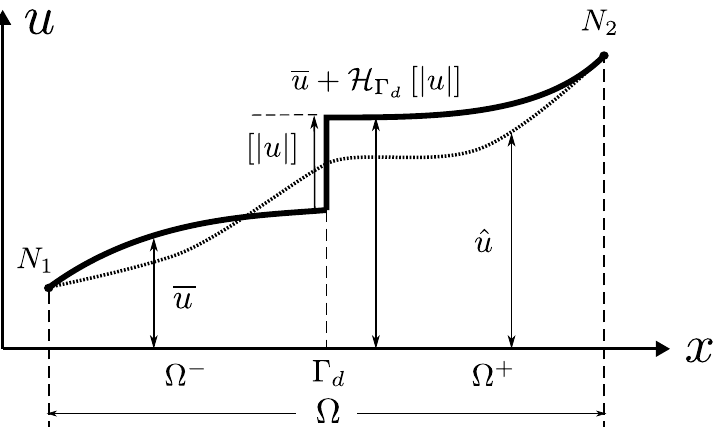
Figure 3. Example of the behaviour of the field u for a 1D element (conformed by nodes N 1 and N 2 ) with a constant displacement jump [